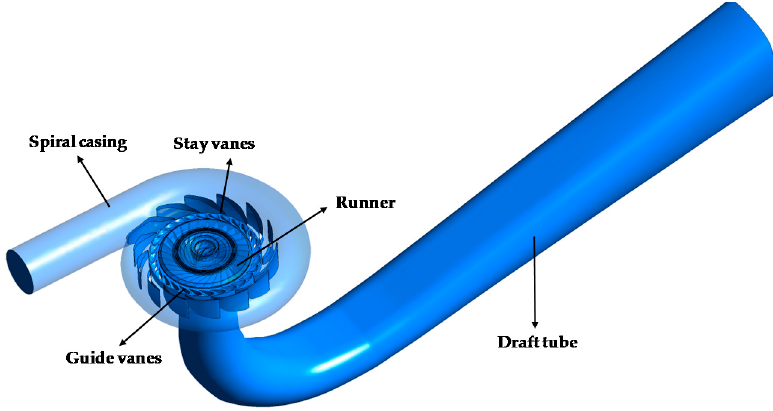
Figure 1. The computational domain of the whole Francis turbine passage.